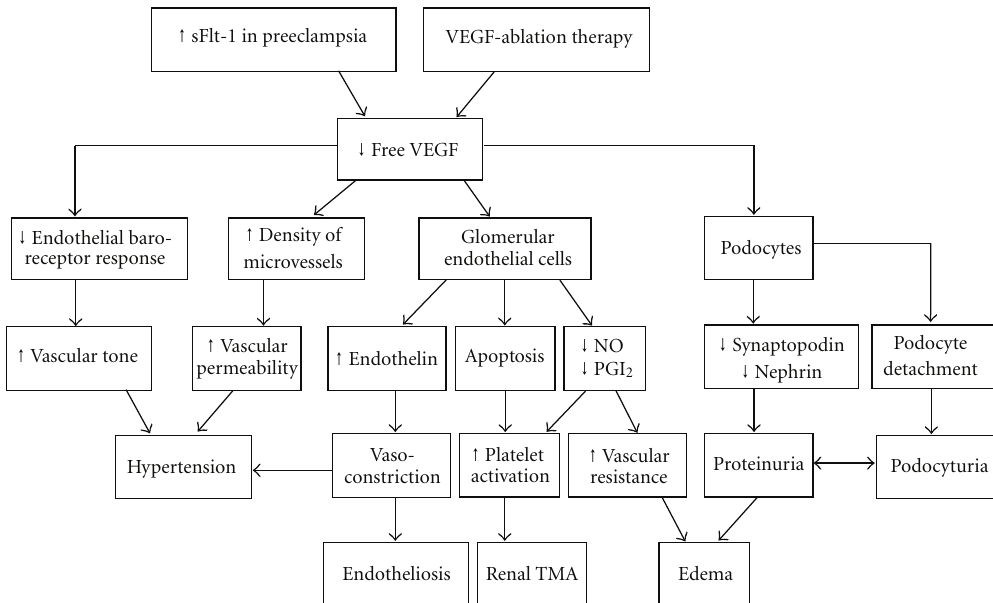
Figure 1: Flowchart demonstrates the renal involvement in preeclampsia and VEGF ablation therapy due to decreased levels of local and circulating VEGF. sFlt-1: soluble fms-like tyrosine kinase-1; VEGF: vascular endothelial growth factor; NO: nitric oxide; PGI 2 : prostacyclin; TMA: thrombotic